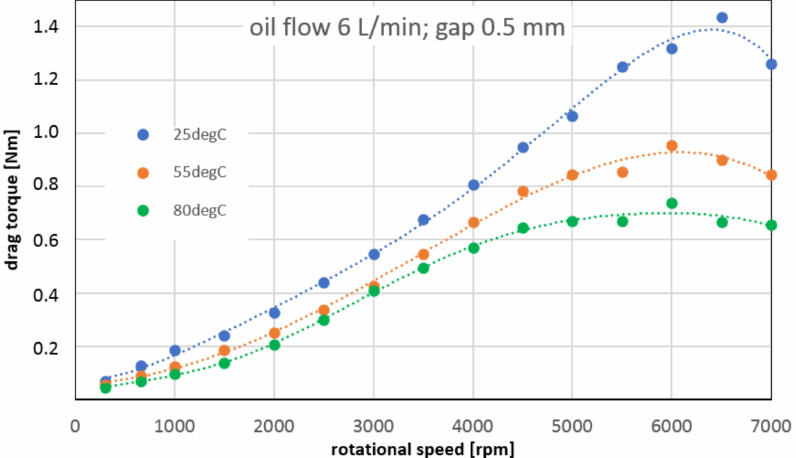
Figure 3. Influence of oil temperature on drag torque characteristics—gap between plates 0.5 mm, oil flow rate 6